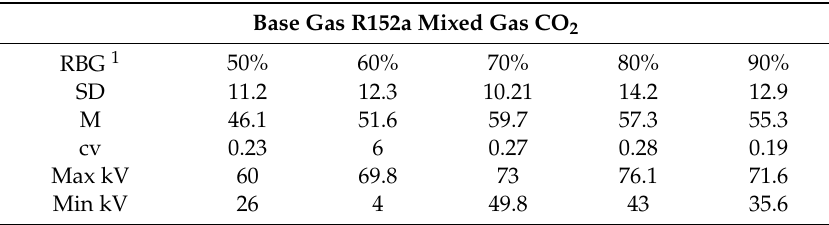
Table 8. Statistical analysis of R152a.